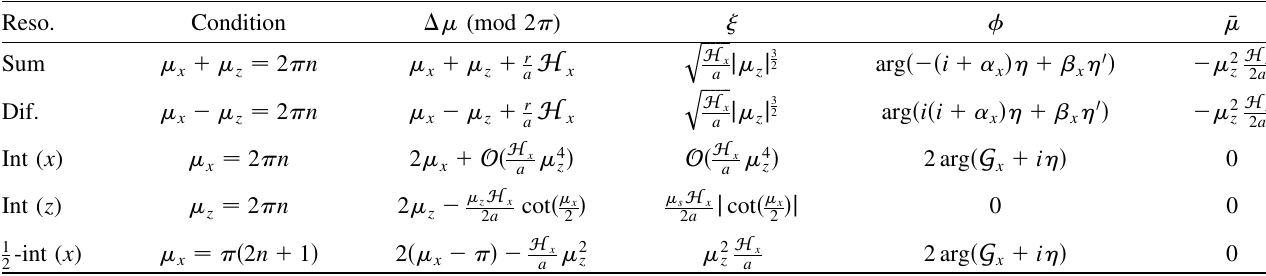
TABLE II. Resonances for dispersive rf